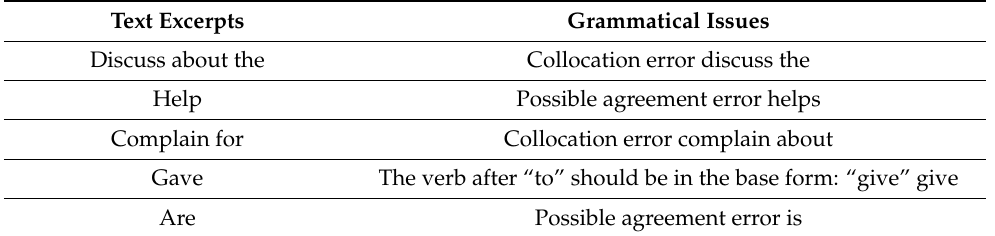
Table 4. Grammatical Issues for Online Exercise Content (Source: Lumos Text Complexity